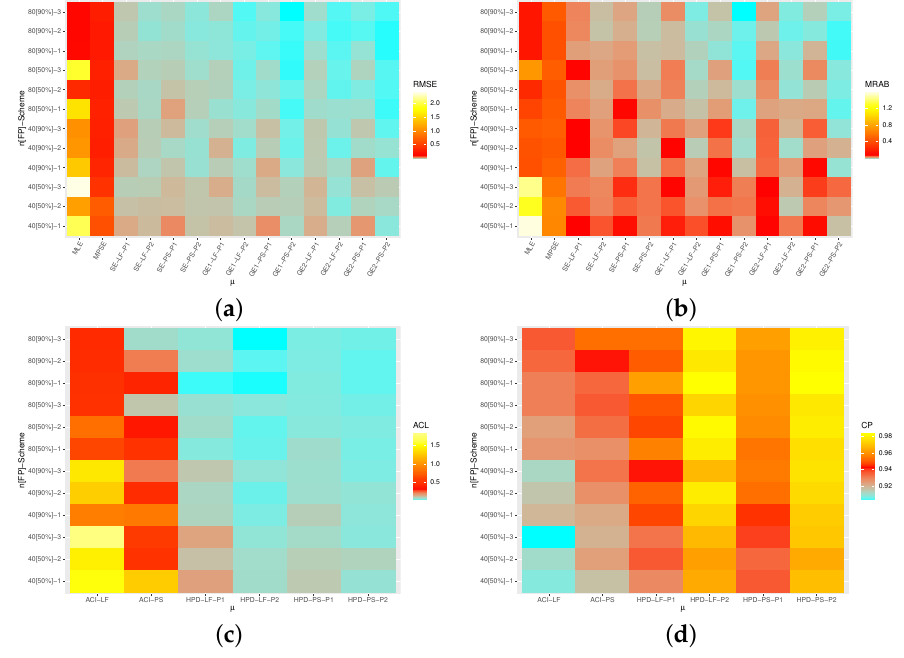
Figure 6. Heatmap for the simulation results of µ . (a) RMSE. (b) MRAB. (c) ACL. (d)